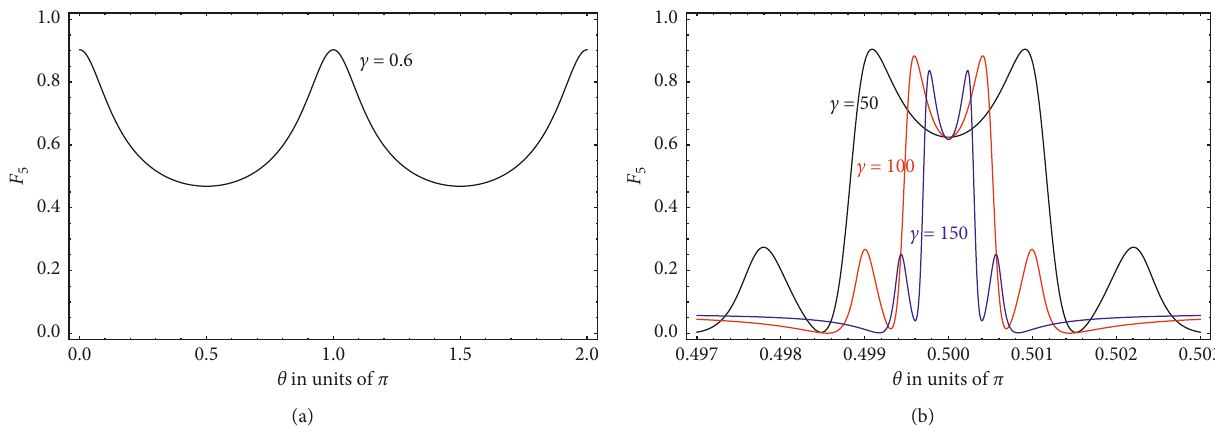
Figure 5: Same with Figure 2 for N � 5; (a) The optimized fidelity (maximum at 91%) profile at the low gain limit, r � 0 . 1. (b) The fidelity profile in the limit of high gain with r � 4 . 5. The black, red, and blue curves are the fidelity profiles for c � 50 , 100 , ​ and150, respectively. The respective maximum fidelities are approximately 91%, 88%, and 84%,